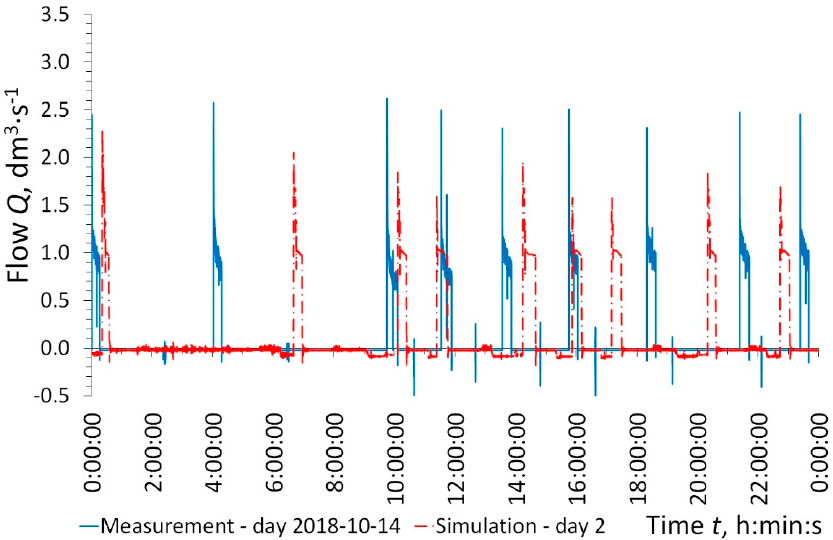
Figure 12. Flows in force main measured on 14 October 2016 and simulated for day 2 using the SWMM 5.1 program.